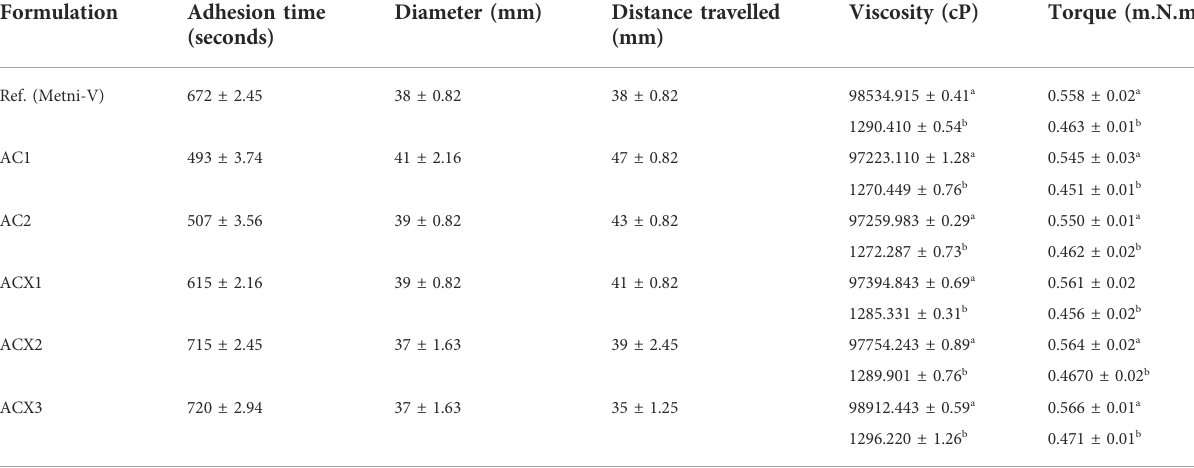
TABLE 2 Summary of rheo-mechanical properties of the formulations (mean ± SD; n = 3). Formulation